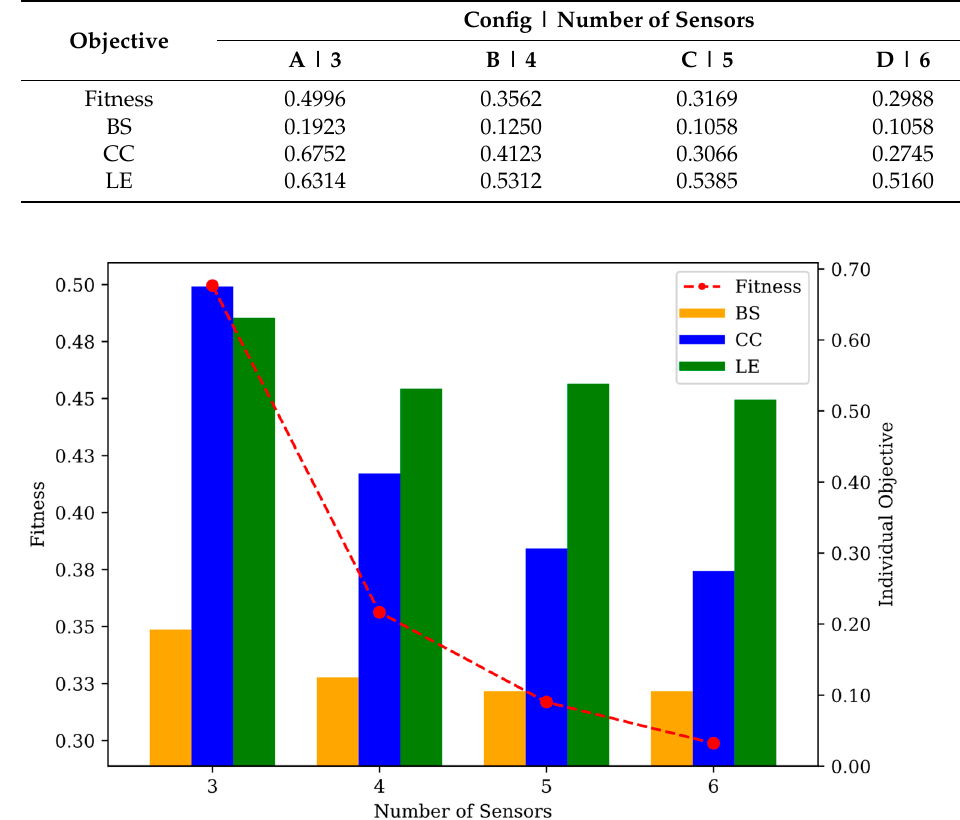
Figure 8. Performance comparison graph for NET-A.